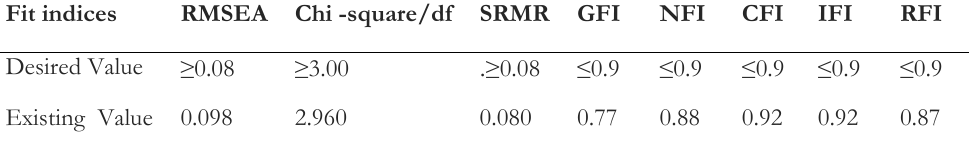
Table 7. Fit indices of research structural